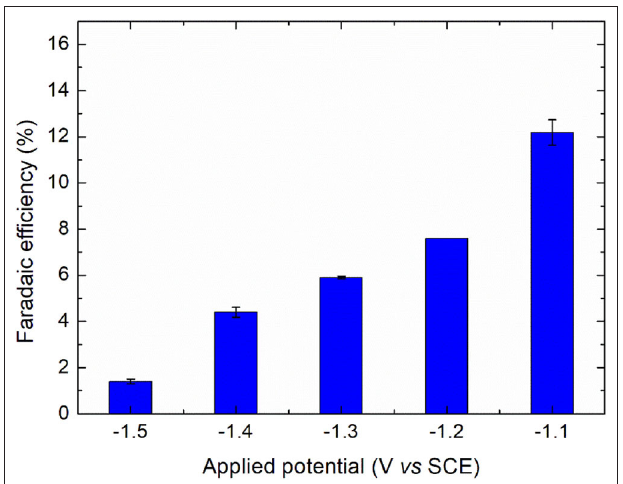
FIGURE 5 | Faradaic efficiencies for the electroreduction of diatrizoate at applied potentials ranging from − 1.1 to − 1.5 V/SCE. Error bars are based on duplicate experiments.